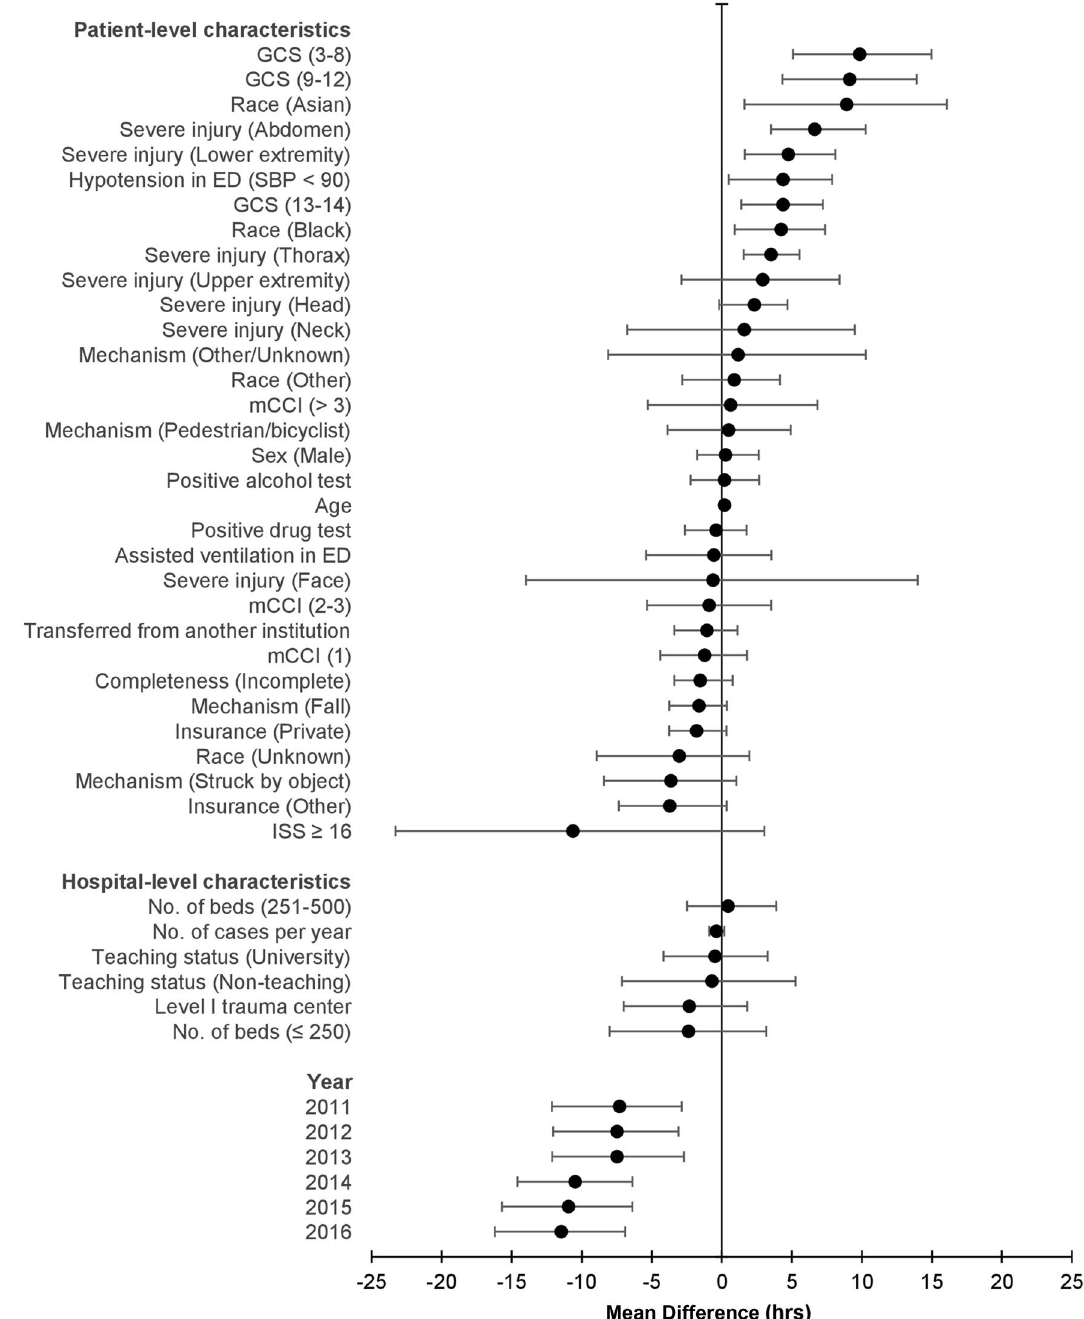
Figure 1. Forest plot of adjusted MDs and 95% CIs for patient- and hospital-level characteristics for time to surgical decompression 45